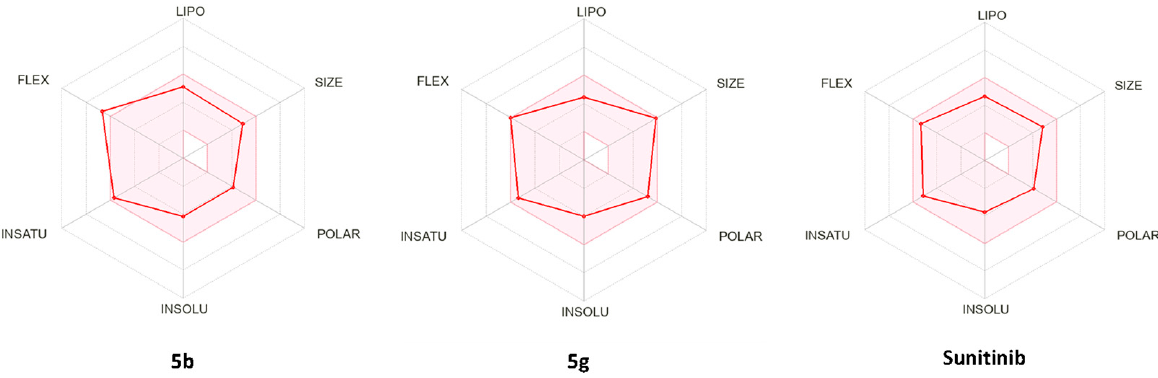
Figure 8. Bioavailability radar of compounds 5b , 5g versus sunitinib.